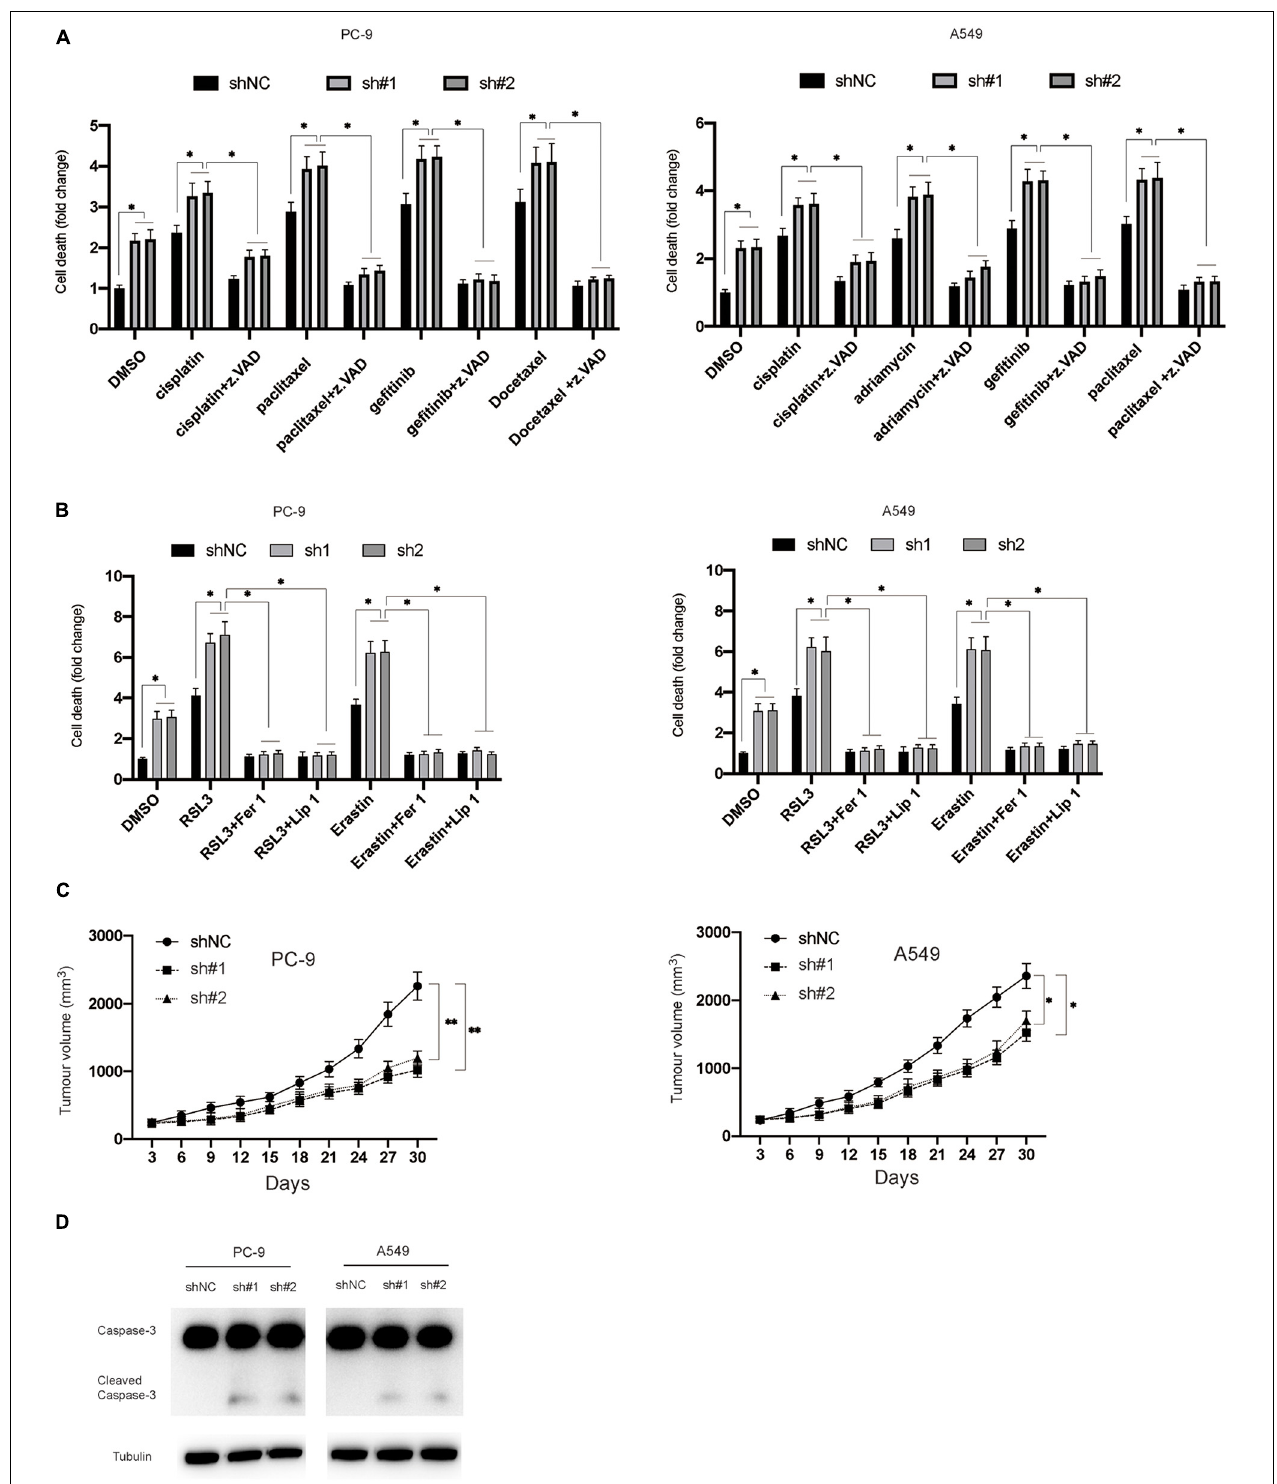
FIGURE 5 | Silencing of circDTL increased the chemosensitivity of NSCLC cells and inhibited the growth of NSCLC in vivo . (A) NSCLC cells were exposed to different chemotherapy agents with or without z.VAD for 24 h and cellular death was measured. (B) NSCLC cells were exposed to RSL3 or Erastin with or without Fer-1/Lip-1 for 24 h, cellular deaths were measured. (C) NSCLC cells stably transfected with shNC or shcircDTL and inoculated into nude mice, tumor volumes were measured at different time points. (D) Xenografts were subjected to western blotting analysis. Data were presented as mean ± SD. Experiments were performed at least three times. ∗ P < 0.05; ∗∗ P <